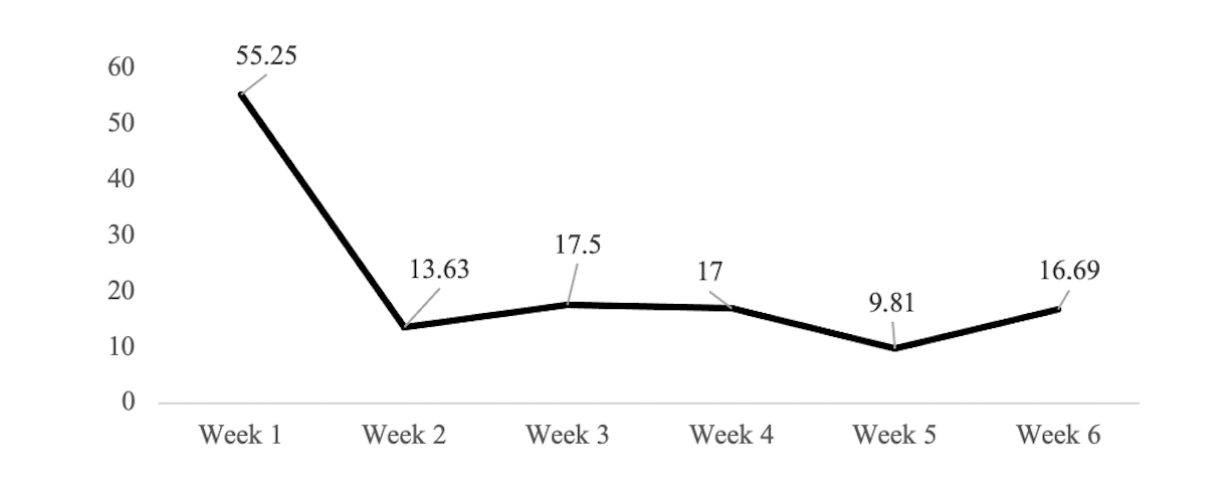
Figure 2. Weekly mean frequency of individual in-app exercises.